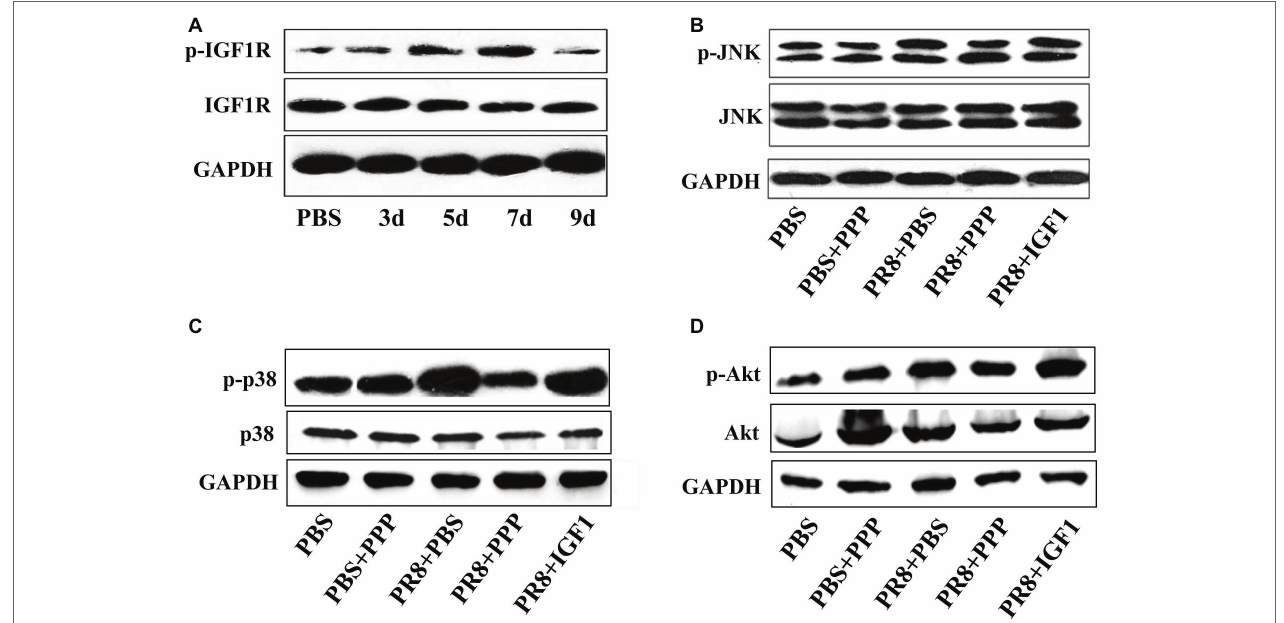
FIGURE 7 | Changes in the level of protein expression in the IGF1 signaling pathway. (A) Changes in the level of IGF1R and p-IGF1R protein over time in the lung tissue of BALB/c mice infected with PR8 (50LD 50 ); groups of BALB/c mice ( n = 6, females, 6–8 weeks) were intranasally infected with PR8 (50LD 50 ) treated with IGF1 or PPP, and at day 5 post-infection, the mice lungs were examined for changes in (B) JNK and p-JNK protein, (C) p38 and p-p38 protein, and (D) Akt and p-Akt protein. The lung sample was mixed from six mice in the group. Figures were representative of three independent